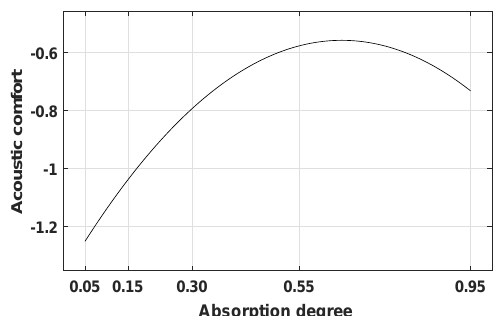
Figure 8. Effect of the absorption coefficient ( α w ) on short-term acoustic comfort, estimated by a linear mixed-effects model.